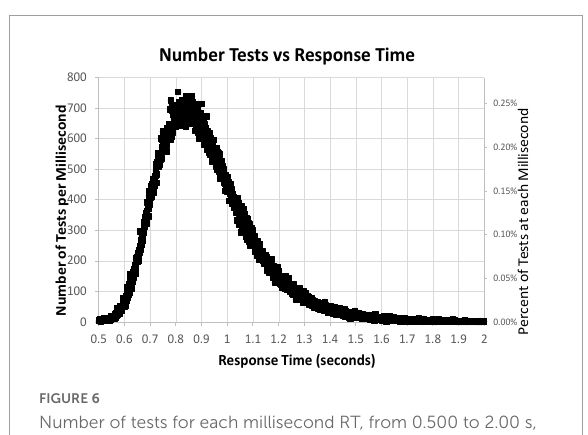
FIGURE6 Number of tests for each millisecond RT, from 0.500 to 2.00 s, for 282,140 user tests. Note that the number of tests has a skewed